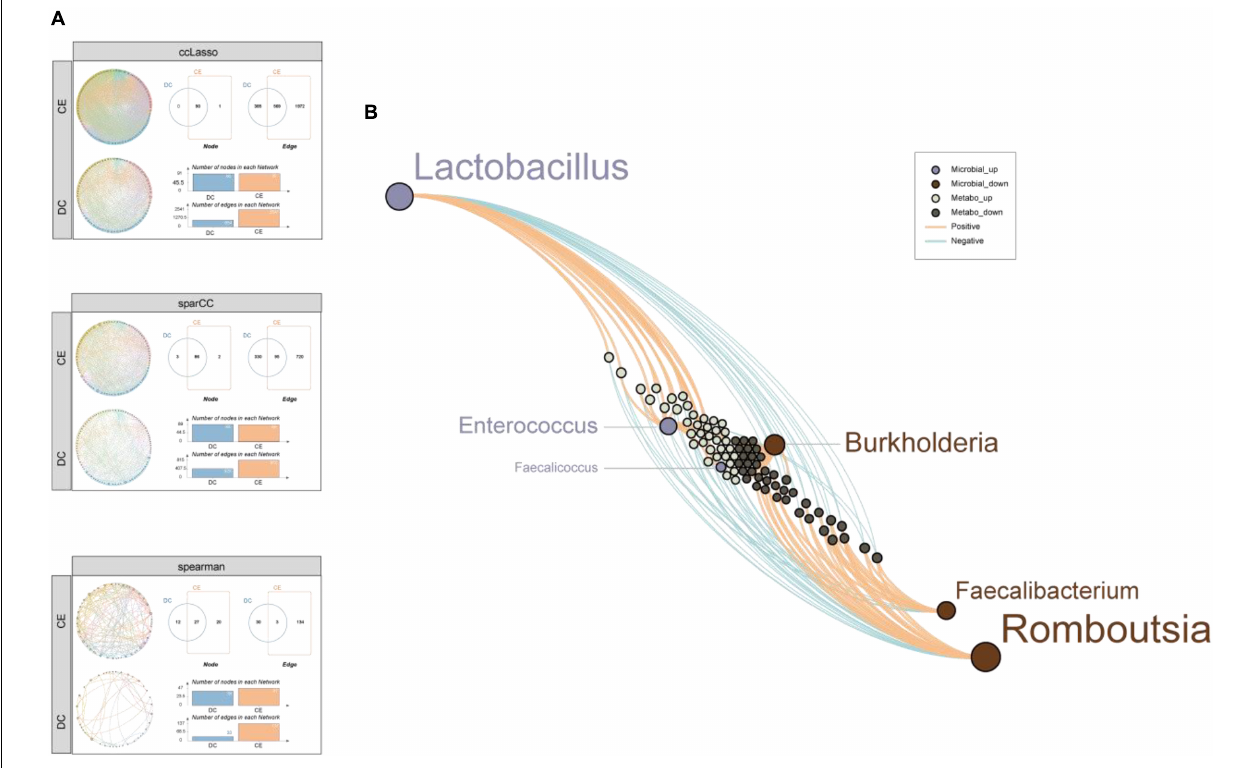
FIGURE 7 | CE enhanced co-expression correlation among the microbial community and the differential metabolites were tightly associated with the signature microbiota. (A) Microbial community co-expression network analysis explores the relationship between CE and DC groups through three standard algorithms. Different nodes represent different bacterial genera, colors represent phyla, and the dots size represent node degree. (B) A network diagram of differential microbiota-metabolites demonstrates that the up-regulated microbial were closely related with the up-regulated metabolites while down-regulated microbial were closely related with the down-regulated